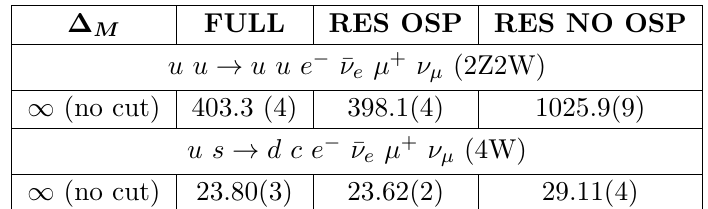
M ‘(cid:23) M W < (cid:1) M ( ‘ = e; (cid:22) ). ‘ (cid:0) j j > 20 GeV ; (cid:17) j < 5 : 5 ; M jj > 600 GeV ; (cid:1) (cid:17) jj > 3 : 6 ; M 4 ‘ > t j j j j